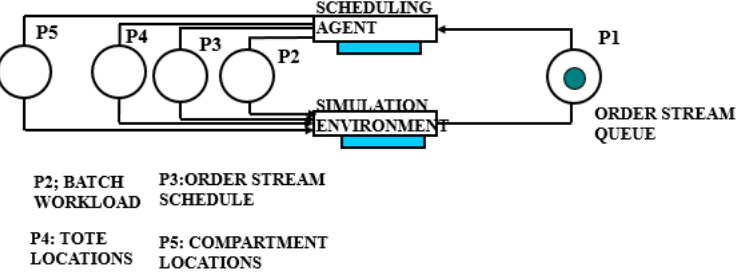
Figure 2. The top page of the implemented hierarchical CTPN model of the scheduling system. Table 3. Basic color set declarations of the CTPN system